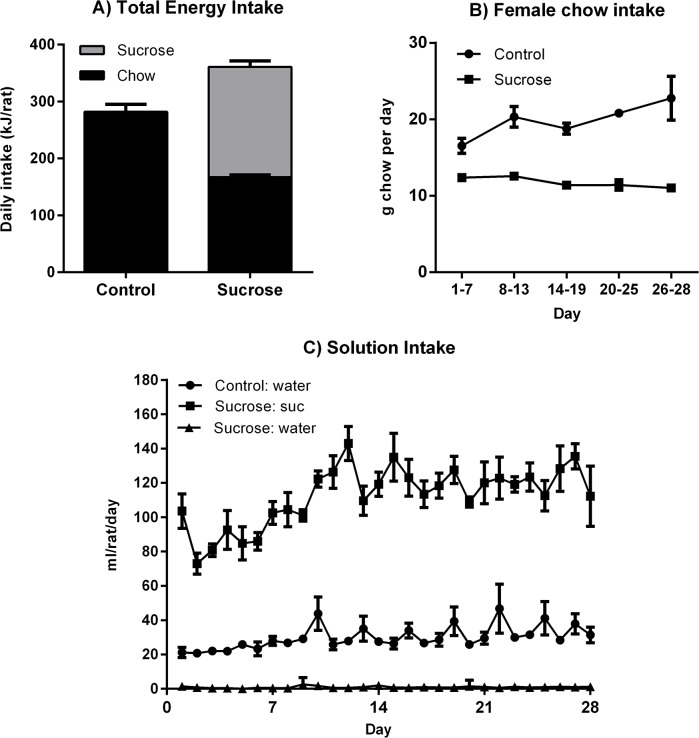
Consumption data during maternal sucrose feeding.Female rats with free access to 10% sucrose solution consumed more calories than water-only Controls (Panel A) and compensated partially for liquid calories by eating less chow (Panel B). The Sucrose group drank sucrose almost exclusively and their liquid intakes were substantially higher than water intakes in Controls (Panel C). **p < .01.